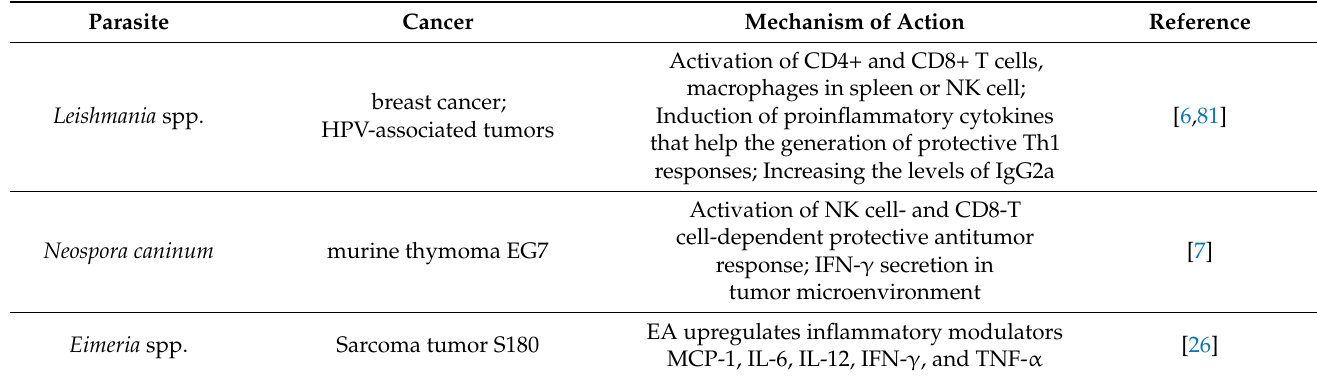
Table 1. Protozoan parasites with antitumor